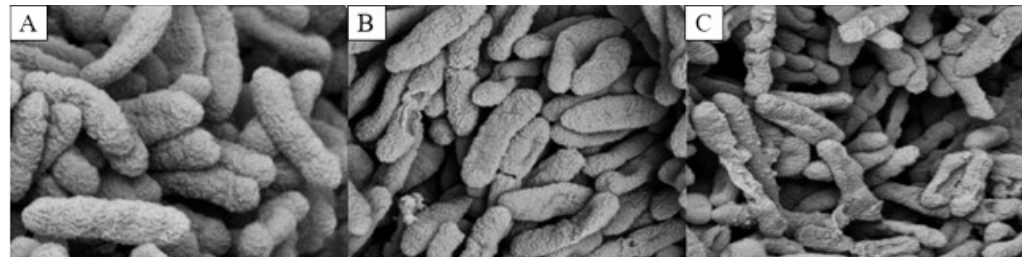
Figure 4. SEM images for Xoo after incubated using different concentrations of compound 4a-2 , ( A ) 0 µg/mL, ( B ) 25 µg/mL and ( C ) 50 µg/mL. Scale bar for ( A ), ( B ) and ( C ) are 5 µ m.